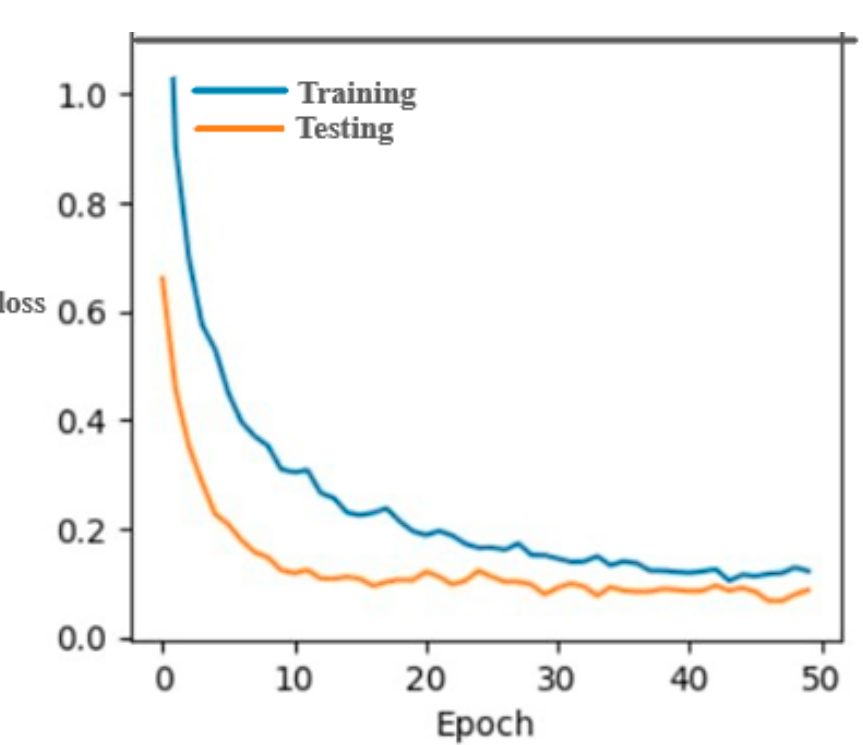
Figure 6. Learning model accuracy.